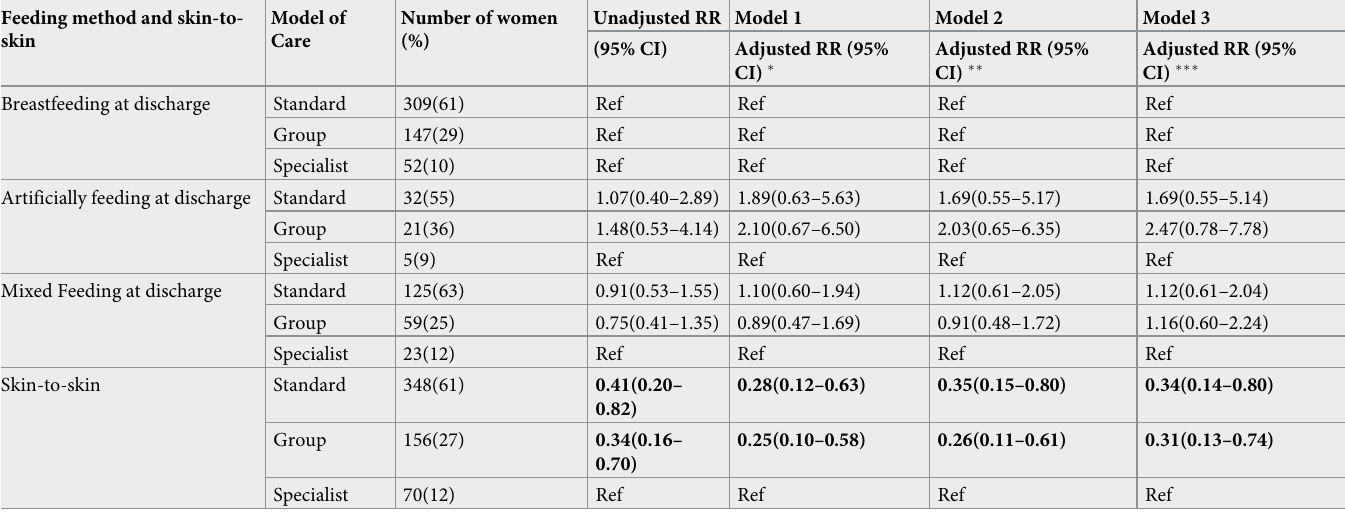
� Model 1: Adjusted for demographics ethnicity, age, parity, IMD score, any social and medical risk factors at booking and onset of labour. �� Model 2: Model 1 + Adjustment for place of antenatal care (community or hospital). ��� Model 3: Model 2 + Adjustment for service provider attended (A or